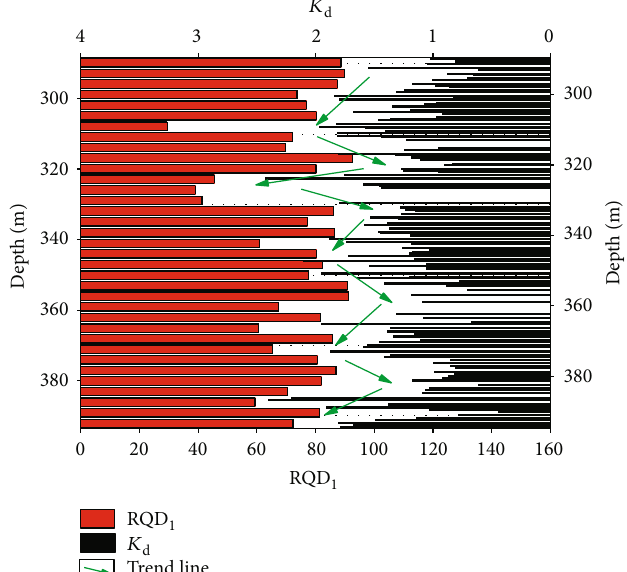
Figure 9: The bar graph of RQD